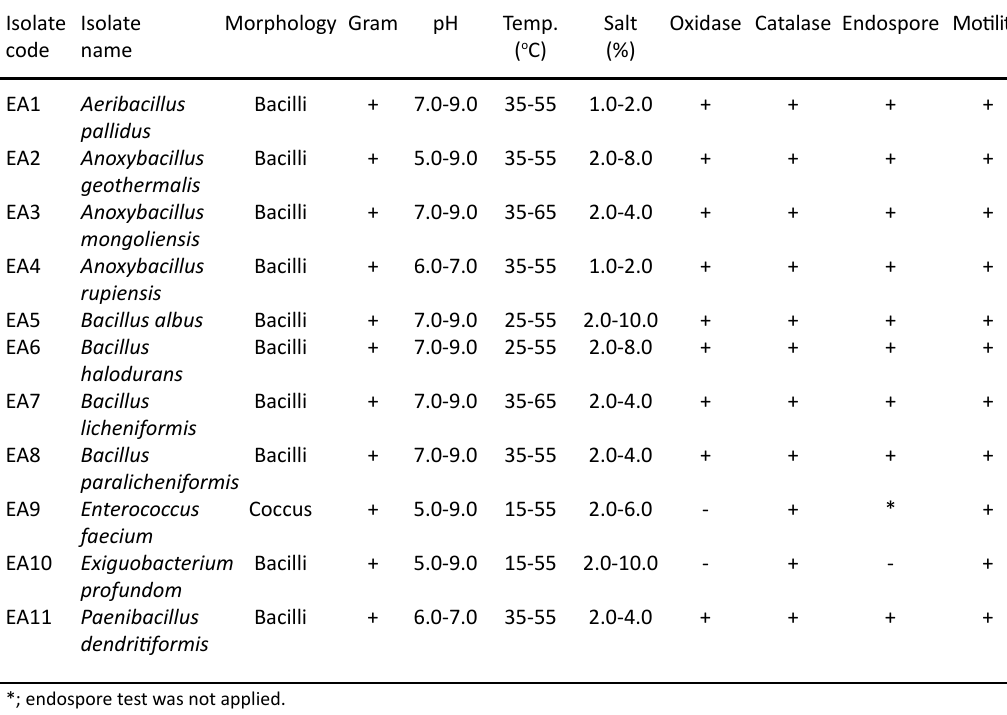
Table 2. Physicochemical requirements and conventional identifications of the isolates Isolate Isolate Morphology Gram pH Temp. Salt Oxidase Catalase Endospore Motility